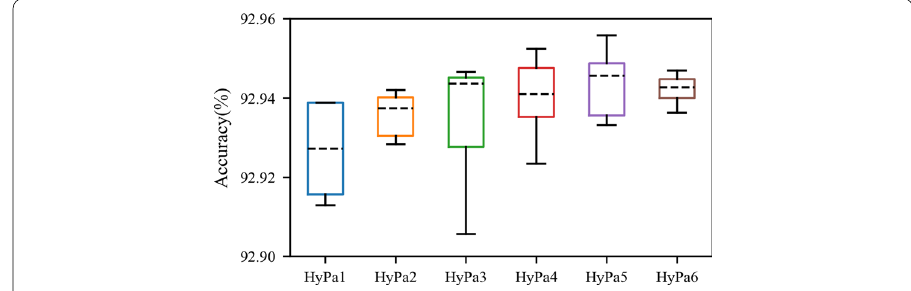
Fig. 7 The box plot of accuracy according to